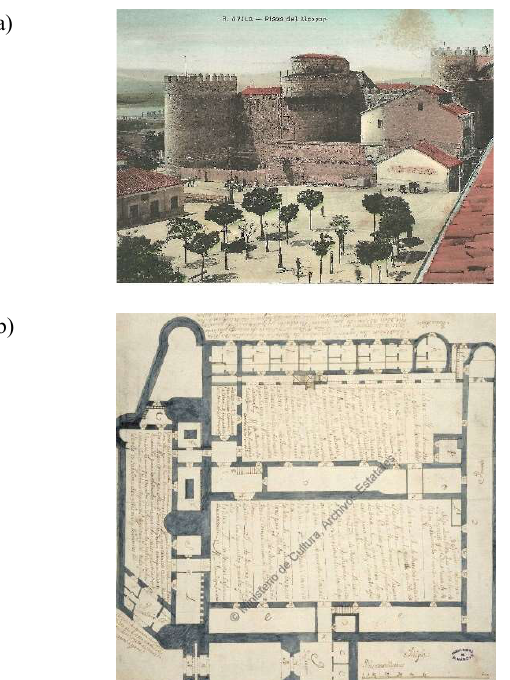
Figure 1. Examples of different types of sources used to feed the platform SmartWall: a) historical photograph used to